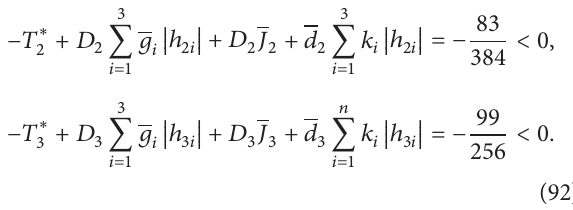
Figure 10: Transient response of state variables V 1 (𝑡) of Example 2.